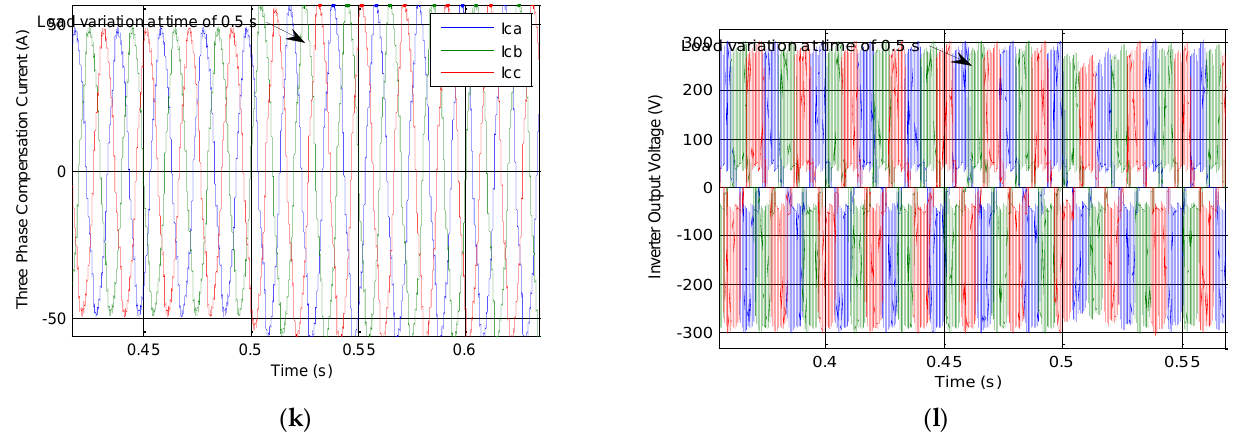
Figure 13. Simulated responses of three phase SSI-based SAPF connected at DRB RL load with SPWM and FLC controller: ( a ) Supply current, ( b ) load current, ( c ) compensation current, ( d ) THD, ( e ) V2 DC links voltage, ( f ) SSI output voltage ( g ) source voltage (V sa ) and source Current (I sa ) of Phase A, ( h ) Zoomed source current, ( i ) zoomed load current, ( j ) inductor current, ( k ) zoomed compensation current and ( l ) zoomed inverter output voltage.